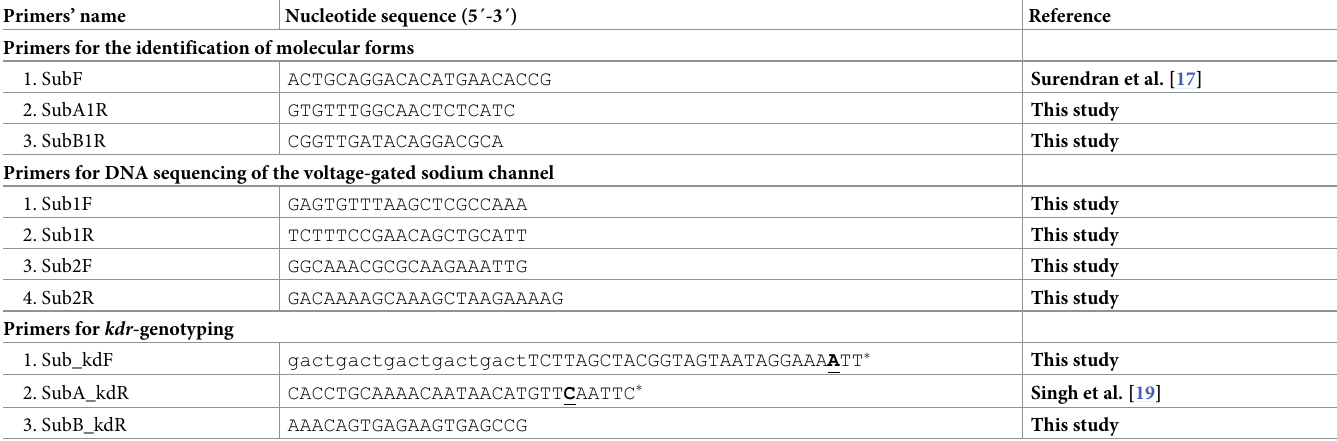
Table 1. List of primers used in this